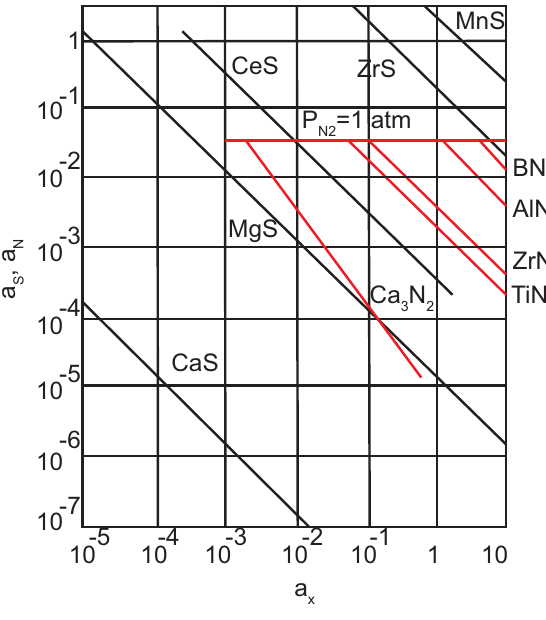
Figure 16. Activity of and N in equilibrium with various elements in liquid Fe at 1600 °C